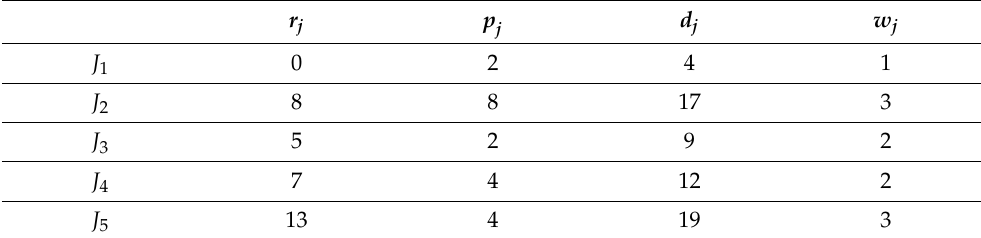
Table 2. Five-job instance where L = 10 and MT = 5.